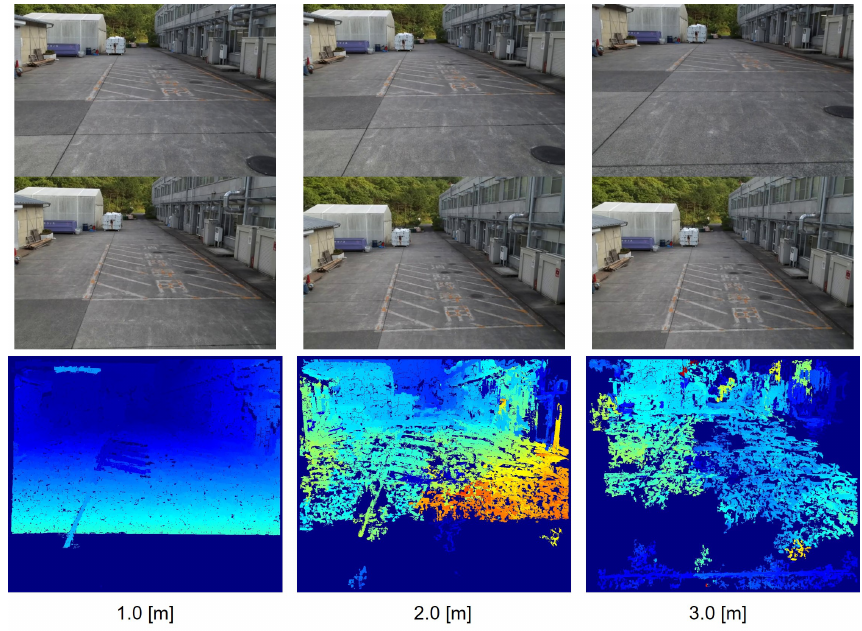
Figure 19. Two image frames and their disparity from each respective baseline.